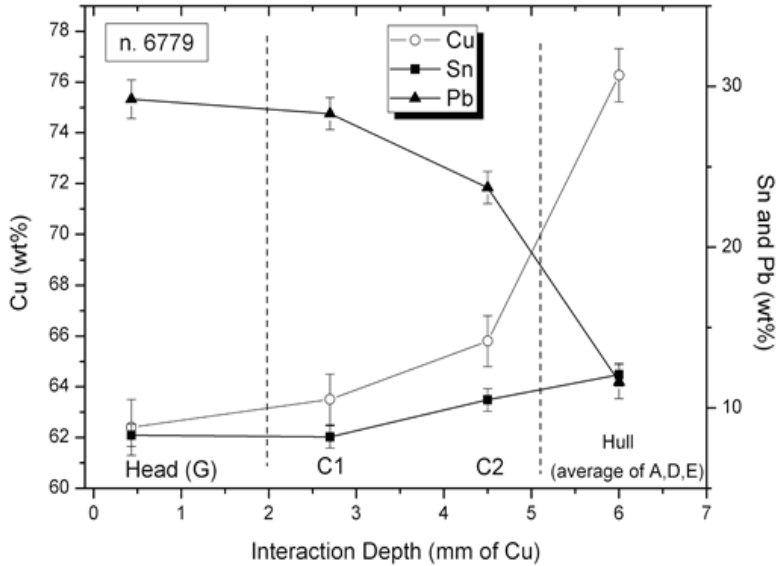
Figure 11. Depth profile of copper, tin and lead concentration (wt.%) of the neck of the boat in boat n.6779. The tin concentration is similar in all the measured areas, while lead and copper vary more significantly.